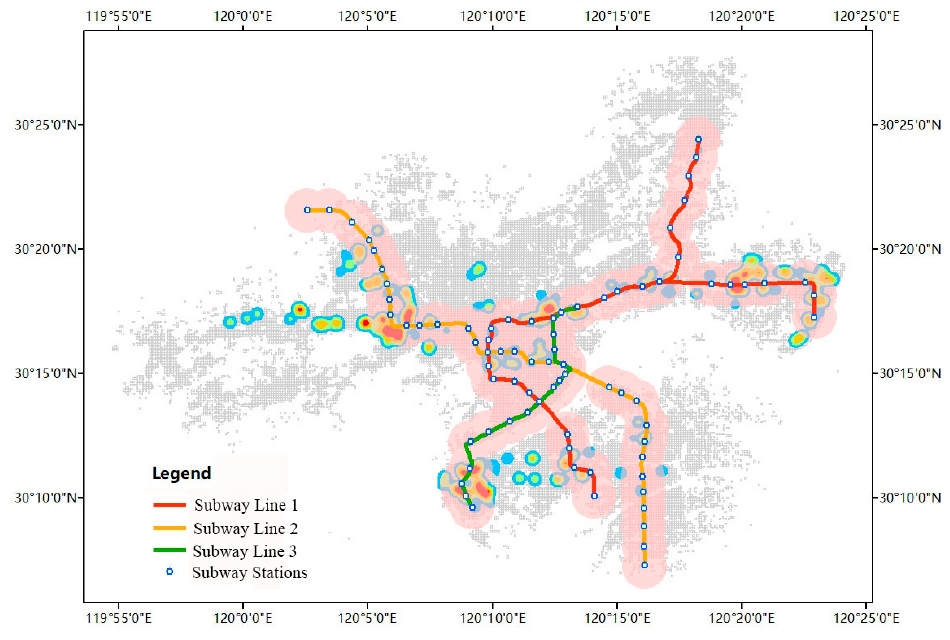
Figure 15. The bu ff er zones of the Hangzhou subway overlaying the heat Figure 15. The buffer zones of the Hangzhou subway overlaying the heat map.